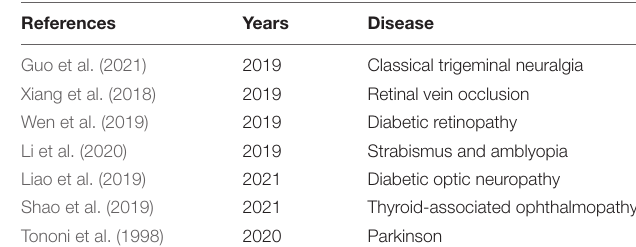
TABLE 1 | REHO method applied in neurogenic disease and ophthalmologic.